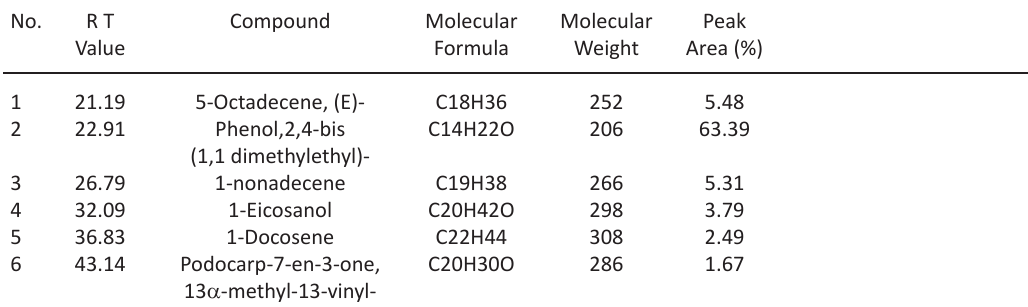
Table 7. Components detected in ethyl acetate crude extract of Streptomyces sp. MK388207 strain (M12)